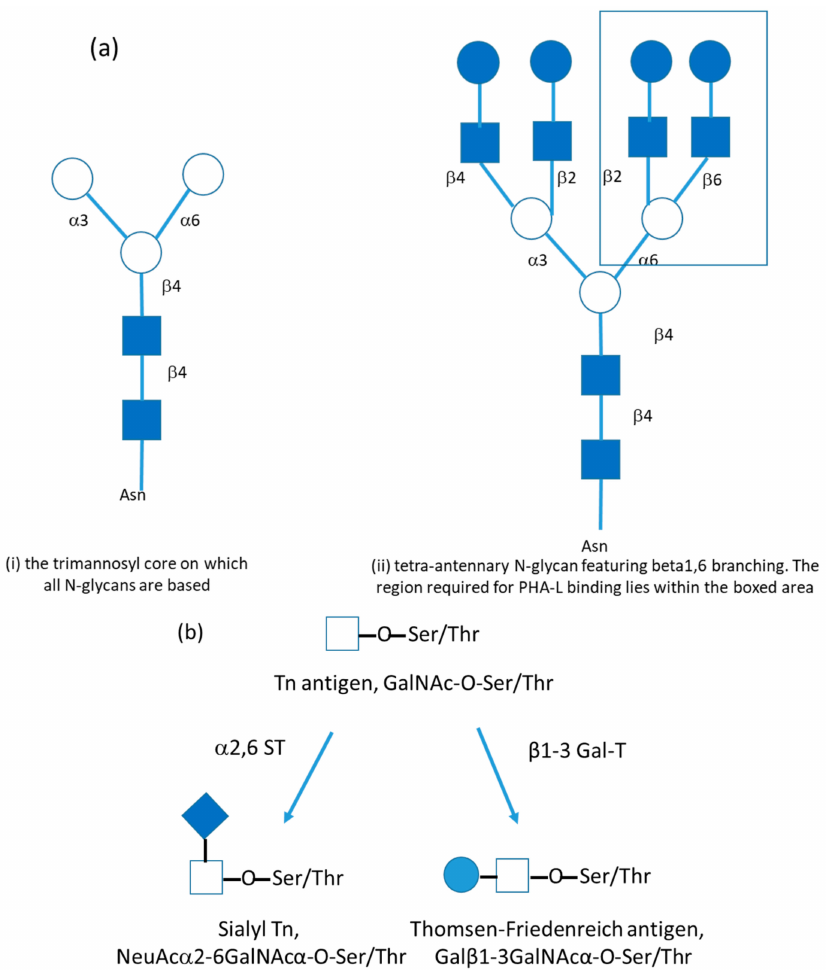
Figure 2. Examples of cancer-associated glycosylation changes ( a ), (i) N-linked glycans are based on a trimannosyl core linked to an asparagine (Asn) residue on the polypeptide. This can be extended by sequential addition of monosaccharides to form a huge variety of complex bi-, tri- tetra-, and penta-antennary structures. (ii) In cancer, N-glycans tend to be larger and more branched than in normal cells. One commonly reported finding is an increase in beta 1,6 branched glycans that can be detected by the binding of a lectin, PHA-L. The region required for PHA-L binding lies within the boxed area. ( b ) The commonest form of O-linked glycosylation begins with the attachment of a single N-acetylgalactosamine residue to a serine (Ser) or threonine (Thr) residue of the polypeptide. This yields the Tn antigen. Tn can be extended in several ways. The addition of a beta1,3 linked galactose, catalysed by beta 1,3 galactosyltransferase ( β 1,3 GalT), yields the Thomsen-Friedenreich antigen. Alternatively, the addition of an alpha 2,6 linked sialic acid (NeuAc), catalysed by alpha 2,6 sialyltransferase ( α 2,6 ST), results in sialyl Tn. Key to symbols: shaded square = N-acetylglucosamine, GlcNAc; open circle = mannose, Man; shaded circle = galactose, Gal; open square = N-acetylgalactosamine, GalNAc; shaded diamond = sialic acid,